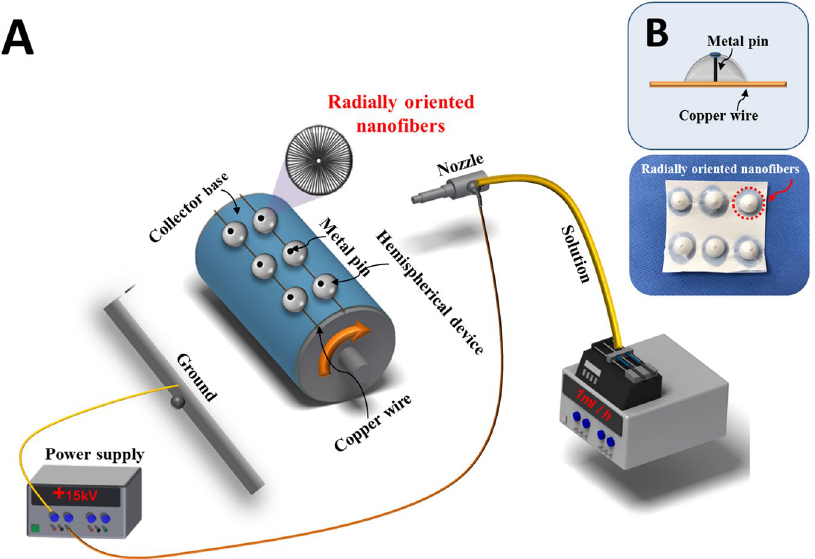
Figure 2. ( A ) Electrospinning setup of the fabrication of 3D radially oriented nanofibrous scaffolds, ( B ) copper wires, and metal pin in the hemispherical device designed to be electrically connected to each